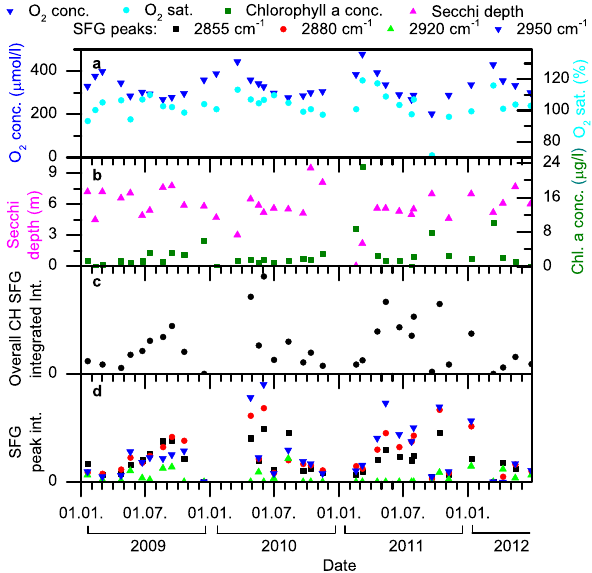
Fig. 2. Time series data of characteristic marine chemical parame- ters and SFG intensities. (a) Oxygen concentration and saturation at a water depth of 1m. (b) Secchi depth and chlorophyll a con- centration at a water depth of 1m. (c) Integrated SFG intensity over the CH stretch region. (d) SFG peak intensities for four different vibrational